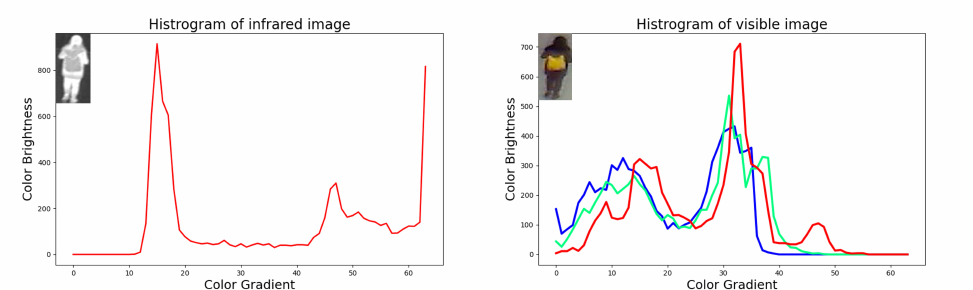
Figure 3. Comparison of visible three-channel brightness-gradient histograms of visible-infrared image pairs with the same ID on RegDB